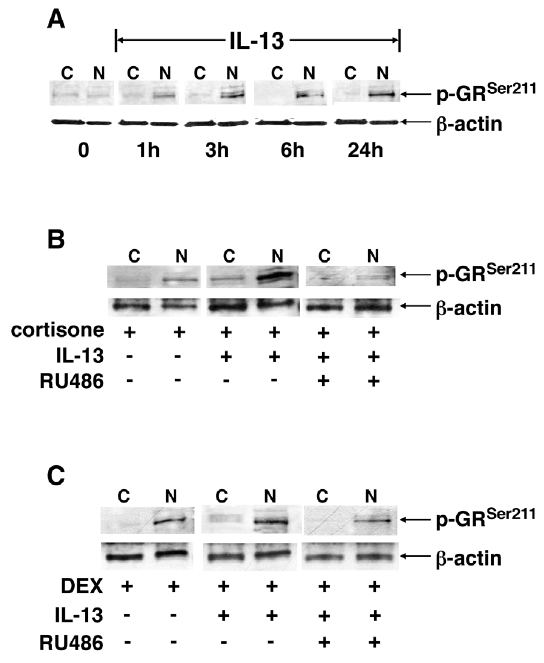
Figure 2. Immunoblot analysis of separate and combined effects of ligand-stimulated and unliganded IL-13-induced GR Ser211 phosphorylation in HASM cells. ( A ) Treatment with IL- 13 elicits progressive increases in p-GR Ser211 for up to 24 h following cytokine exposure that are detected in the nuclear (N) and not the cytoplasmic (C) fraction. Induction of p-GR Ser211 by cortisone ( B ) or DEX ( C ) is increased in HASM cells initially exposed for 24 h to IL-13; and the p-GR Ser211 response is markedly suppressed in cells pretreated with the GR antagonist, RU486.